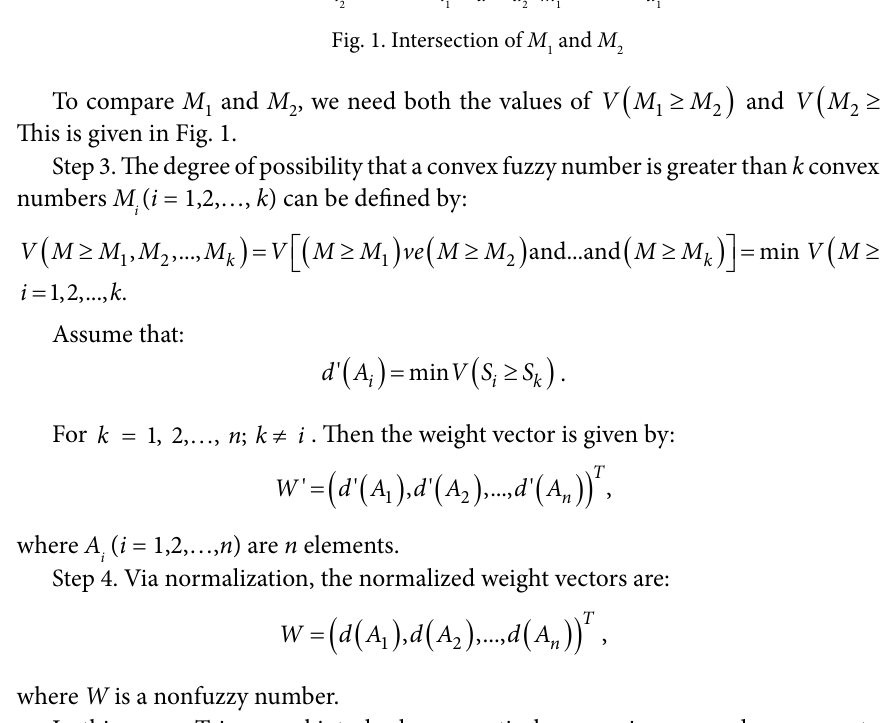
Fig. 1. Intersection of M